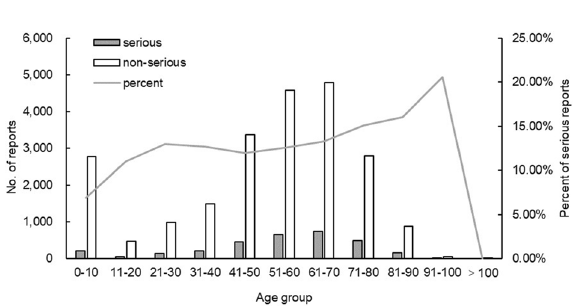
Figure 4. Number of reports and the proportion of serious reports in each age group.